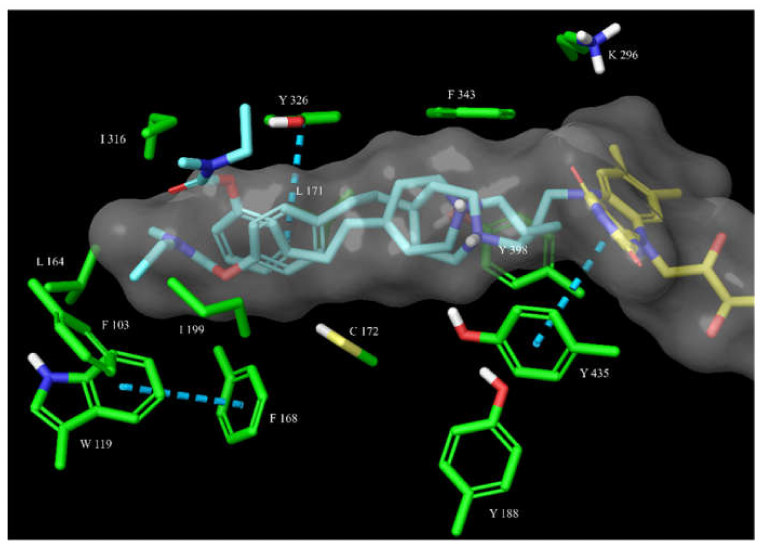
Figure 4. The overlay of docked covalently bound 14 and 15 (shown as cyan sticks) in the hMAO-B active site. The active site is shown as surface with the relevant amino acid residues shown as green sticks and the FAD cofactor as yellow sticks. The π - π interactions are represented by blue dashed lines. The bound para -substituted 14 better fits into the active site cavity, forming a π - π interaction with Tyr326, while the protonated nitrogen forms a cation- π interaction with Tyr398 and a hydrogen bond with